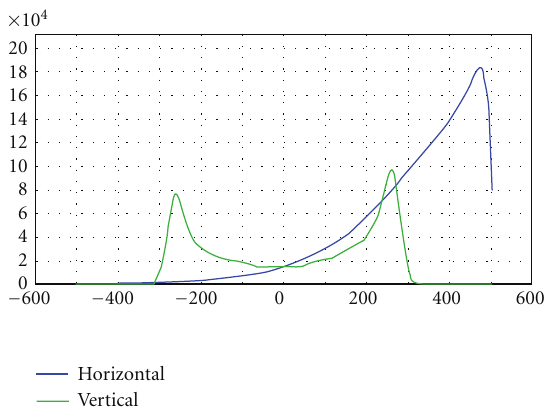
Figure 4: Irradiance profiles on a longitudinal plane parallel to the axis of the ideal CPC. Blue line: irradiance profile along the y = 0 direction of the in the irradiance map. Green line: irradiance profile along the x = 0 direction of the in the irradiance map. Figure 5: Normalized integral power incident on a small longitudi- nal section of the ideal CPC coplanar to the CPC